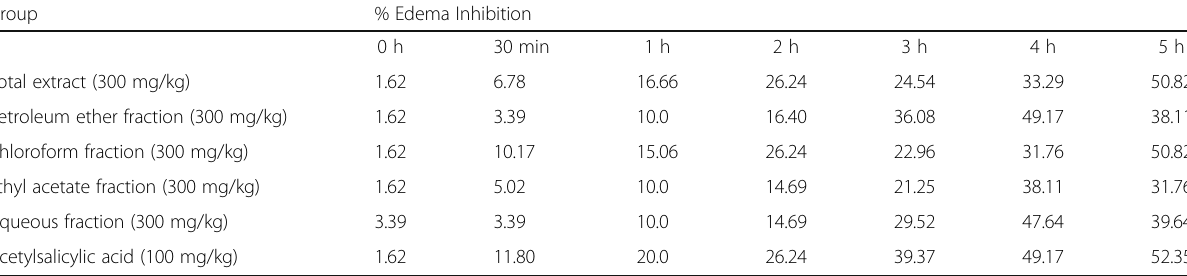
Table 2 Results representing the percentage of edema inhibition of the total ethanolic extract and different fractions of A. hirtum leaves Group % Edema